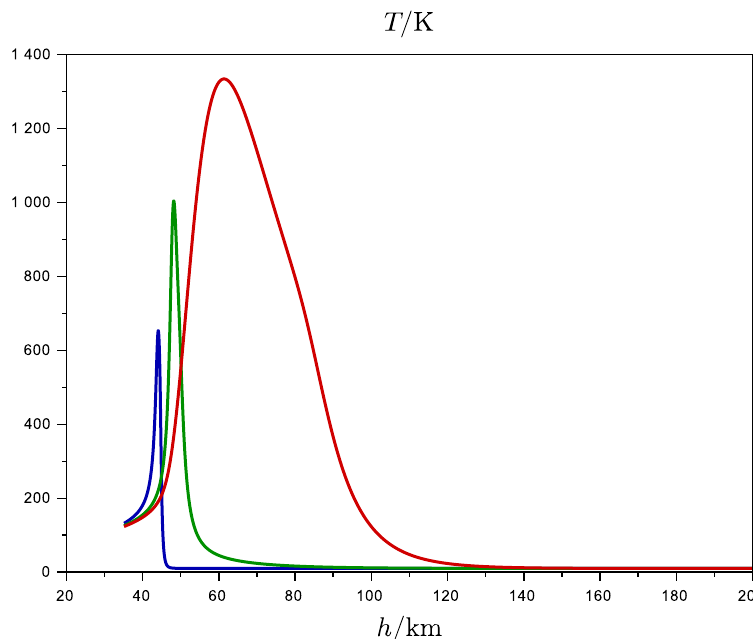
Figure 2. Temperature profile during atmospheric entry versus altitude for micrometeoroids of initial velocity 3.0 km s − 1 (blue), 6.0 km s − 1 (green), and 9.0 km s − 1 (red) ( R 0 = 35 µ m, θ 0 = 45.0 deg).